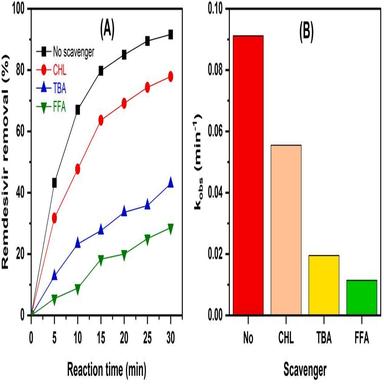
The effect of scavengers on the UVA-photocatalytic activity of Ti-ɣAl2O3 in removing RDV (pH: 7; RDV: 10 mg/L; catalyst: 50 mg/L; CHL, TBA or FFA (when added): 1 M).